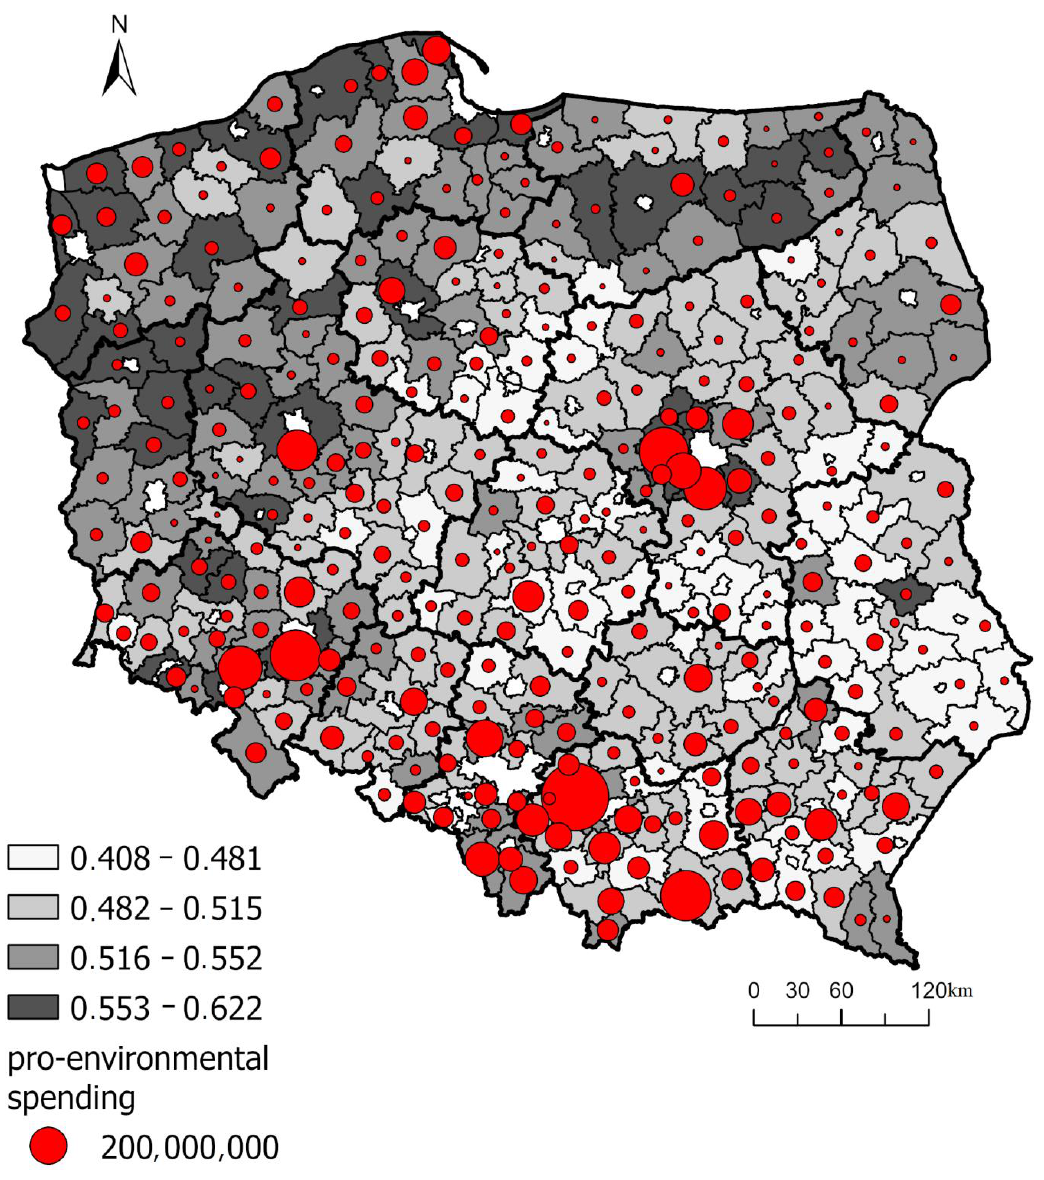
Figure 9. Relationship between the implementation of green economy principles and pro- environmental spending. Source: own elaboration. An analysis of the spatial distribution of agri-environmental-climate measures in Polish counties revealed that the implemented eco-schemes: − exerted a strong effect on the development of agriculture (W agr ) and the economic dimension of the quality of life (W e ), − exerted a moderate effect on the environmental dimension of the quality of life (W n ),